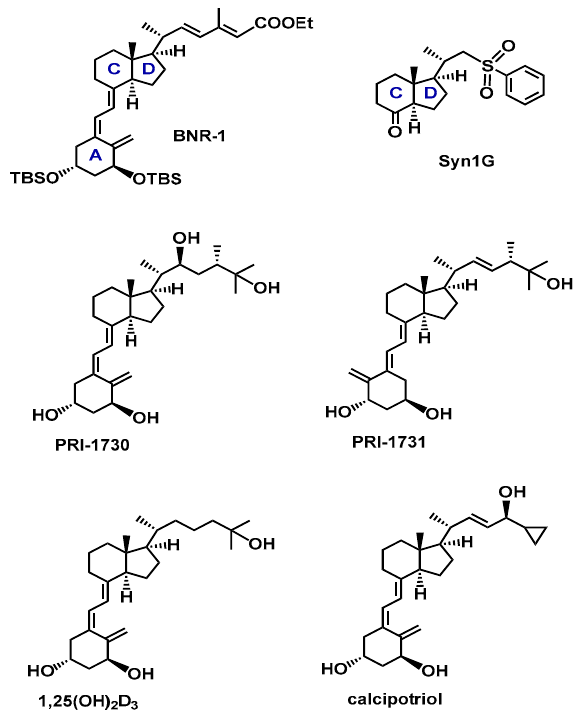
Figure 2. Structures of advanced (BNR-1) and basic (Syn-1G) intermediates of vitamin D as well as vitamin D 2 analogues (PRI-1730, PRI-1731 and calcipotriol) and 1,25(OH) 2 D 3 with the A and C, D rings labeled.